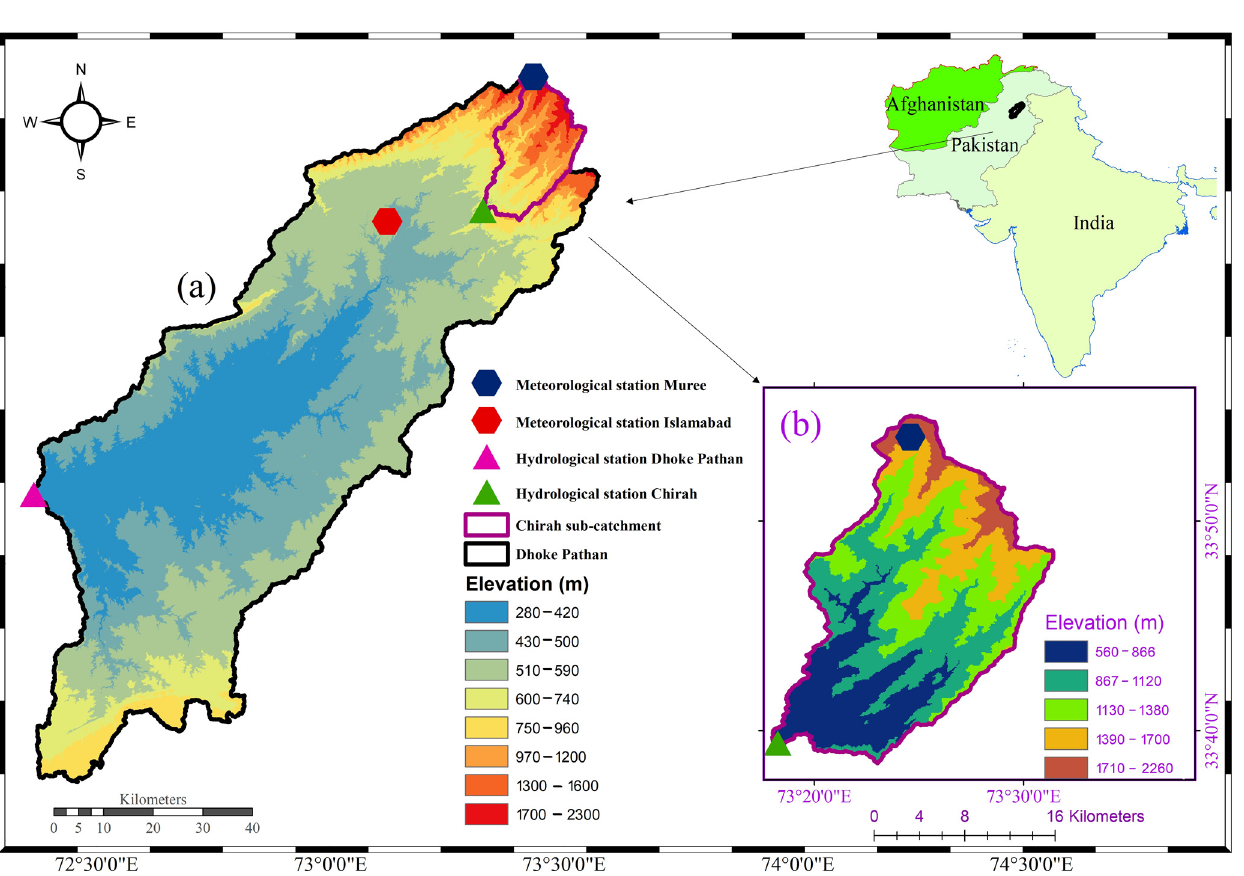
Figure 1. Location and characteristics of the study catchments, ( a ) Soan River Basin with both Chirah and Dhoke Pathan sub-catchments with overall elevation ranges ( b ) Chirah sub-catchment with its elevation ranges.